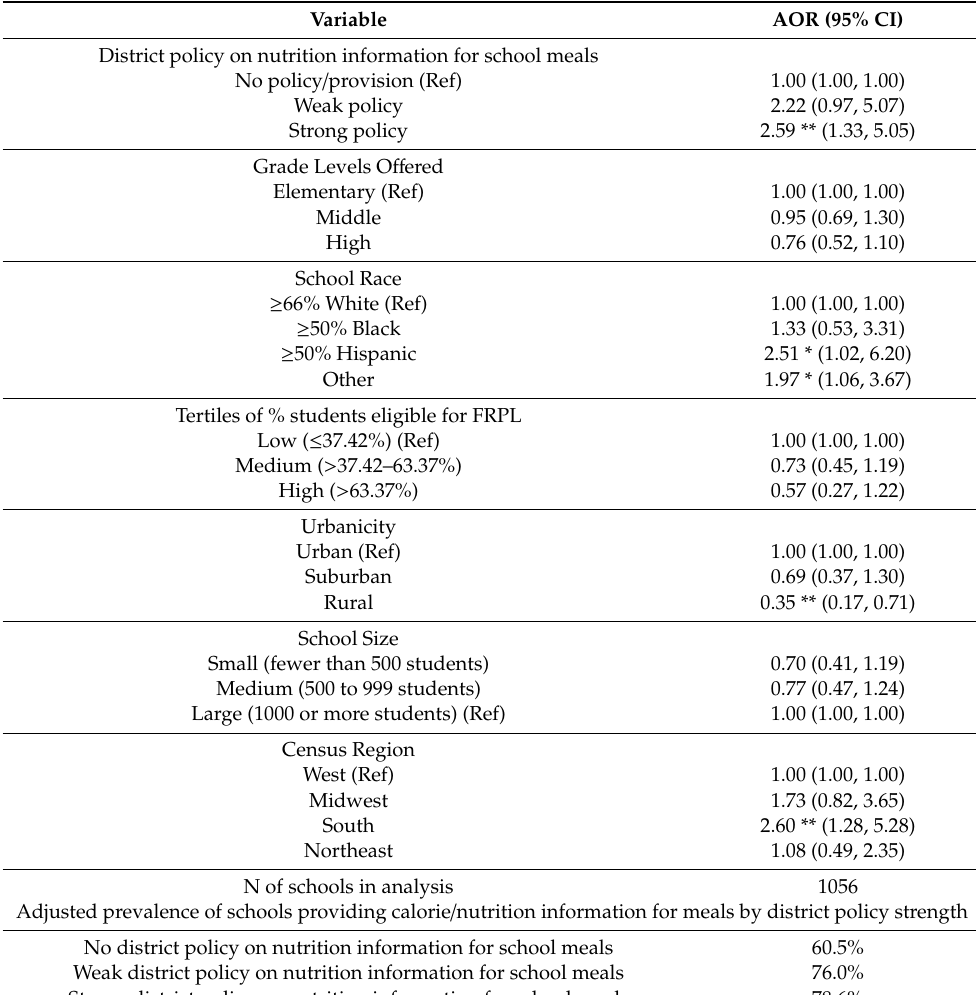
Table 3. Logistic Regression Results for the Association between District Policy on Nutrition Information for SchoolMealsandSchoolsRoutinelyProvidingCalorie /